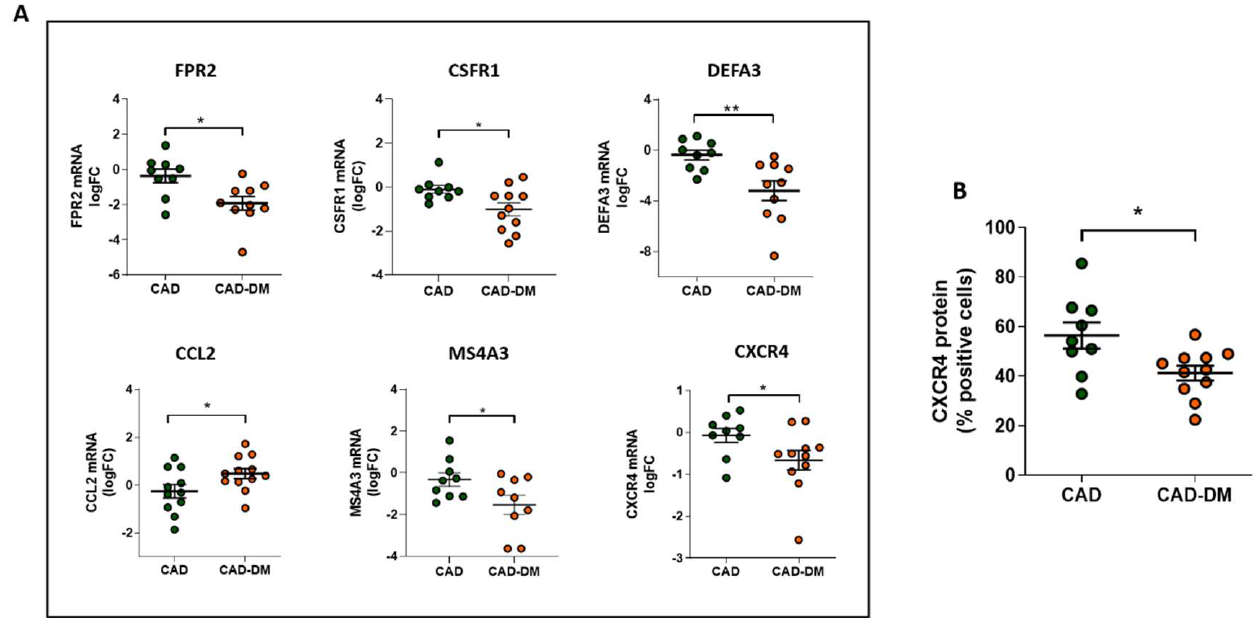
Figure 6. Panel A: Analysis of FPR2, CSFR1, DEFA3, CCL2, MS4A3, and CXCR4 mRNA expression in CD34 + HSPCs from CAD and CAD-DM by qPCR. Data are expressed as log2 fold-change (logFC). CAD has been used as controls (* p < 0.05; ** p < 0.01 vs. CAD; unpaired t test). Panel B : CXCR4 membrane expression level in CD34 + HSPCs from CAD and CAD-DM by flow cytometry (* p < 0.05 vs. CAD; unpaired t test). Data are expressed as percentage of positive